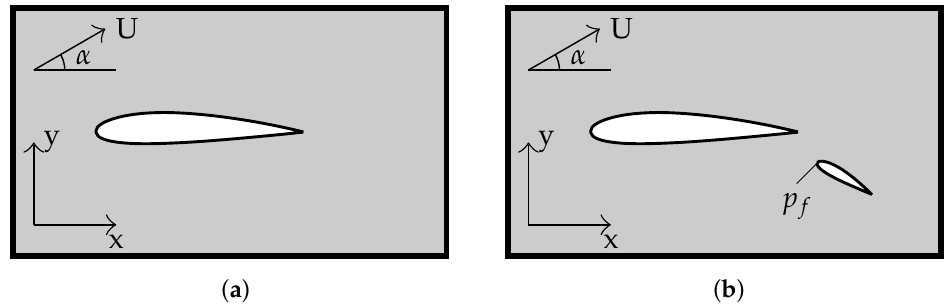
Figure 1. Schematic airfoil and flap CFD use case with parameters. ( a ) Airfoil for p ( b ) Airfoil and flap for p d = w/